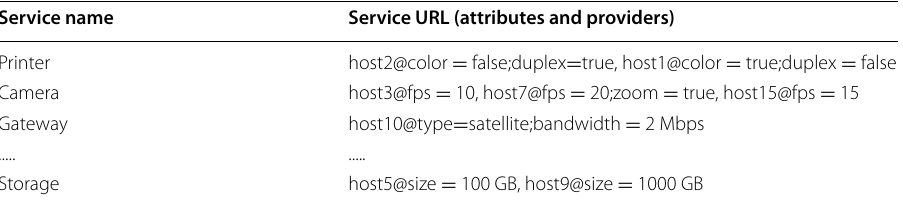
Table 1 Typical service directory Service name Service URL (attributes and